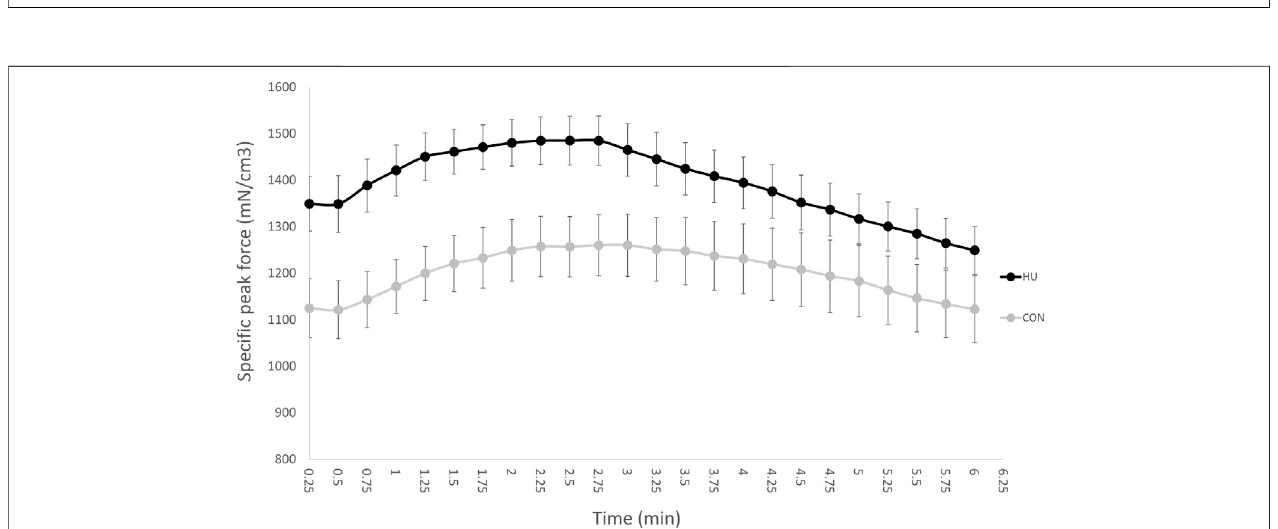
Frontiers in Physiology |